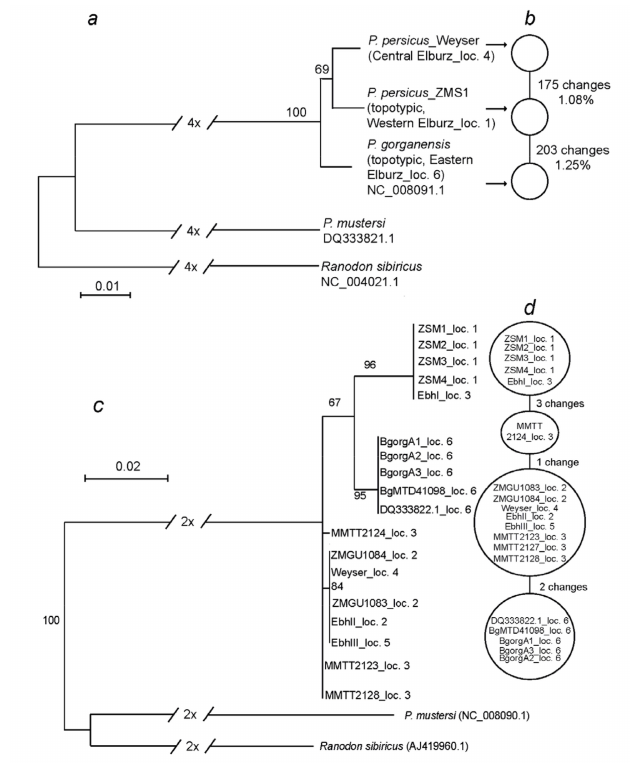
Figure 2. Phylogeny of Central Asian and Iranian hynobiid salamanders and network of Iranian Paradactylodon . ( a